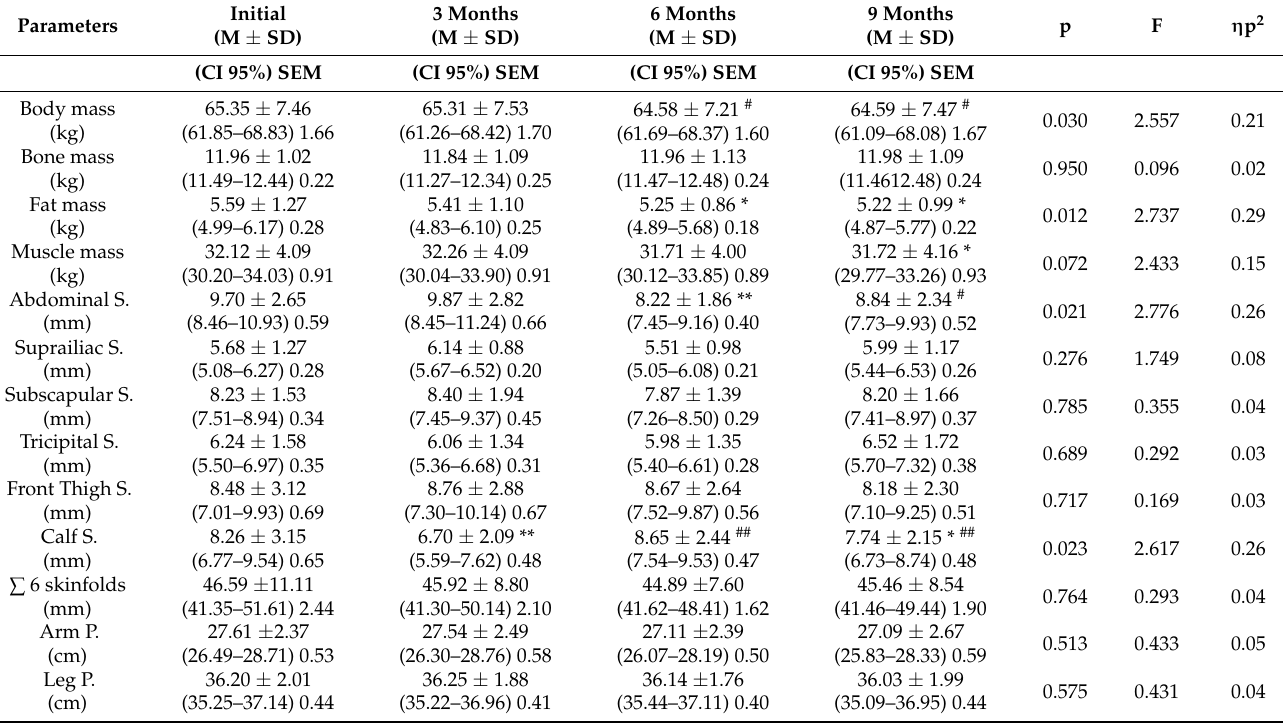
Table 4 shows the different weights, skinfolds and perimeters of the runners at the four time points during the sports season. Table 4. Body composition parameters of the runners during the